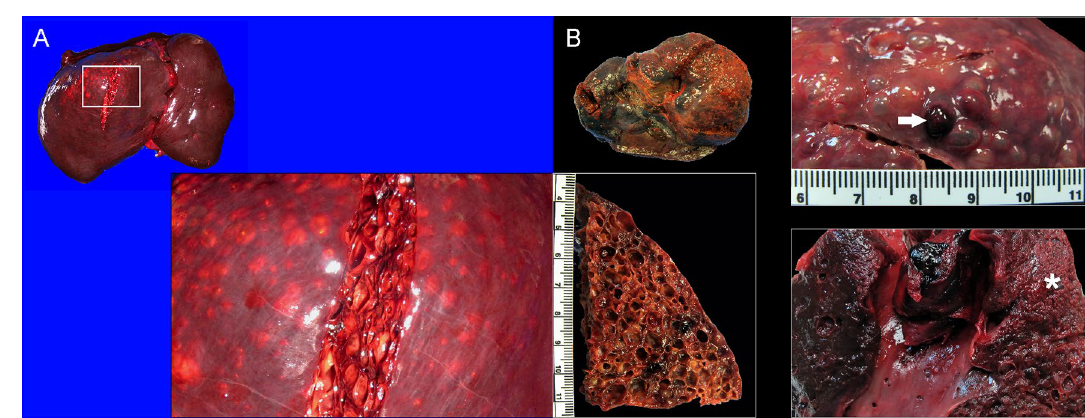
Figure 1. Macroscopic features of cystic liver lesions in dolphins. ( A ) Case 3, liver, cranio-caudal view. The parietal aspect of the right liver lobe is expanded by 0.5 to 2 cm in diameter encapsulated, gas-filled cystic nodules. Inset: detail of cystic nodules on cut surface. ( B ) Case 4, liver, caudo-cranial view (visceral aspect). The entire right liver lobe is expanded by 0.2 to 1 cm in diameter cystic nodules. Right upper inset: detail of surface of cystic nodules, including cavities filled with hemorrhage (arrow). Right lower inset: Obliterative thrombus with the right hepatic venous sinus and major branches. The adjacent liver parenchyma is necrotic (infarct, asterisk). Left lower inset: detail of cystic nodules on cut